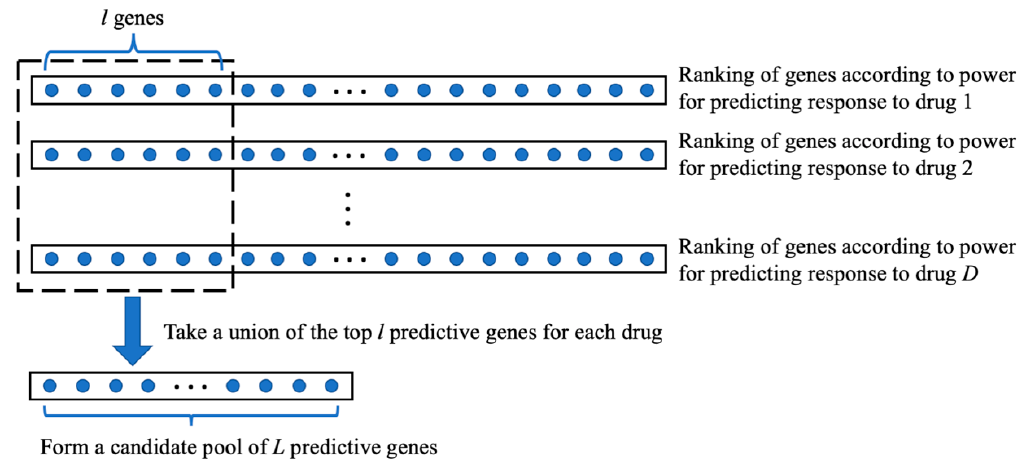
Figure 2. An illustration of generating the candidate gene pool by taking a union of top predictive genes for each drug.